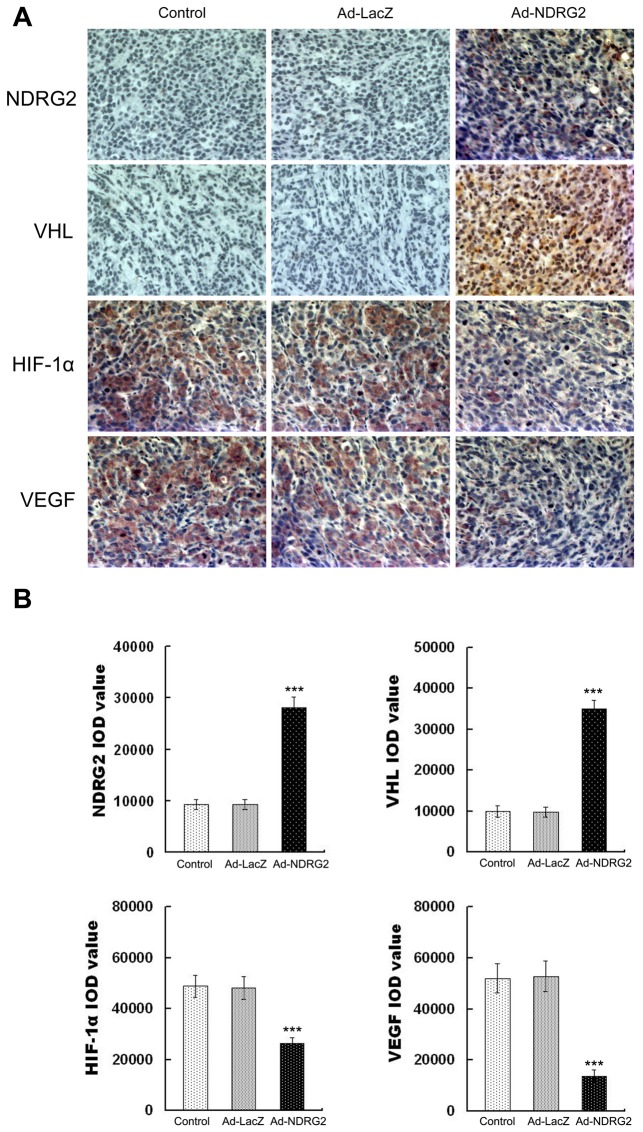
Effects of Ad-NDRG2 intratumoral injections on NDRG2, pVHL, HIF-1α and VEGF expression of 786-O cell xenografts in mice.(A) Intratumoral expressions of NDRG2, pVHL, HIF-1a and VEGF were assessed by Immunohistochemistry (200× magnification) on paraffin-embedded 786-O cell tumor sections. Representative images are shown. (B) Integrated optical density (IOD) values of NDRG2, pVHL, HIF-1α and VEGF protein expression of the tumors were evaluated. ImagePro Plus software was utilized to analyze the IOD values of the positive areas of immunohistochemical staining, and the resulting histograms are shown. Statistical analysis was carried out using one-way ANOVA. The results were shown as the mean ± SD. ***P < 0.001.